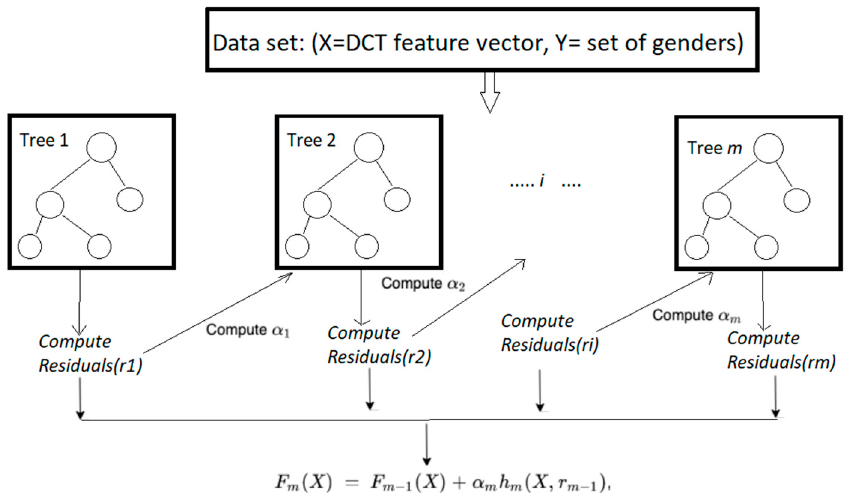
Figure 5. Illustration of XGBoost classifier with gradient